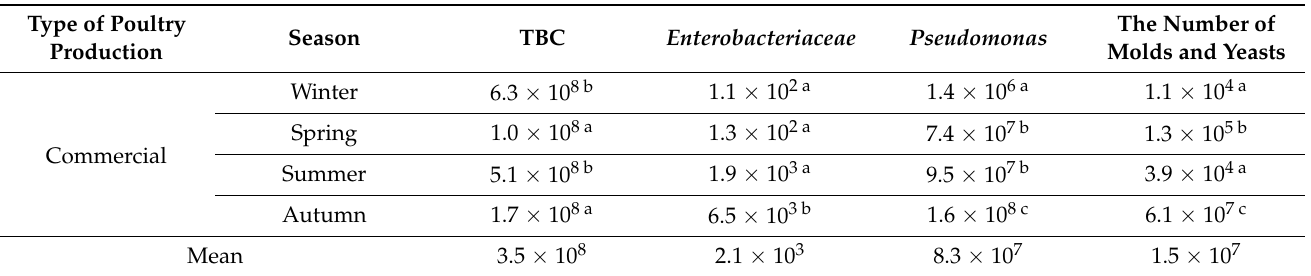
Table 3. Average microbial contamination (CFU/g) of settled dust collected from outside the poultry house only for commercial farms; for backyard farms, no results were recorded.